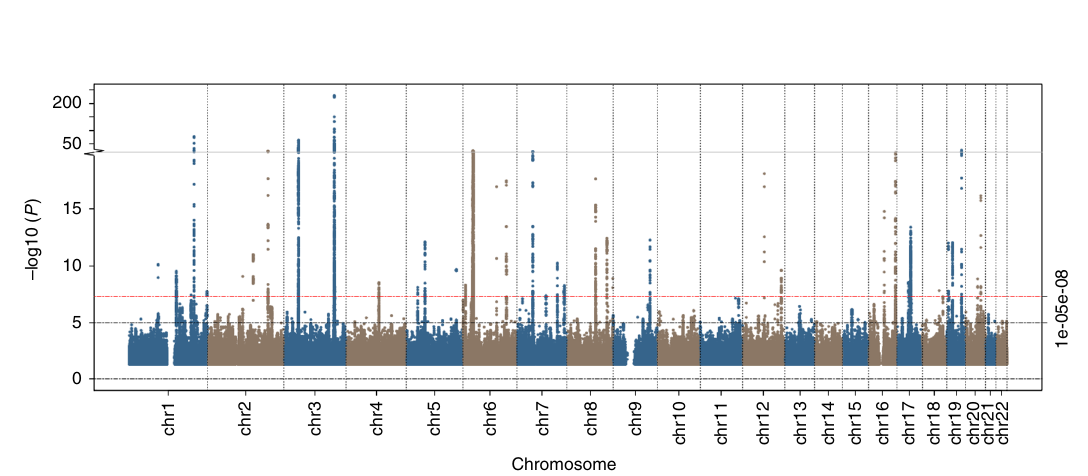
Fig. 1 Manhattan plot of genome-wide association analysis of self-reported ulcers in UK Biobank